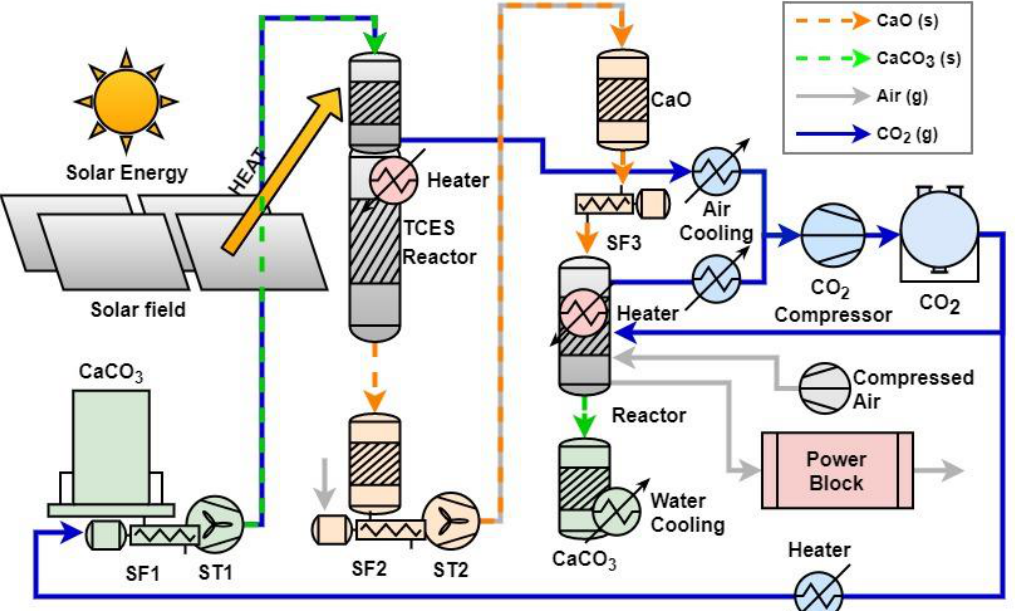
Figure 2. SOCRATCES pilot plant scheme.